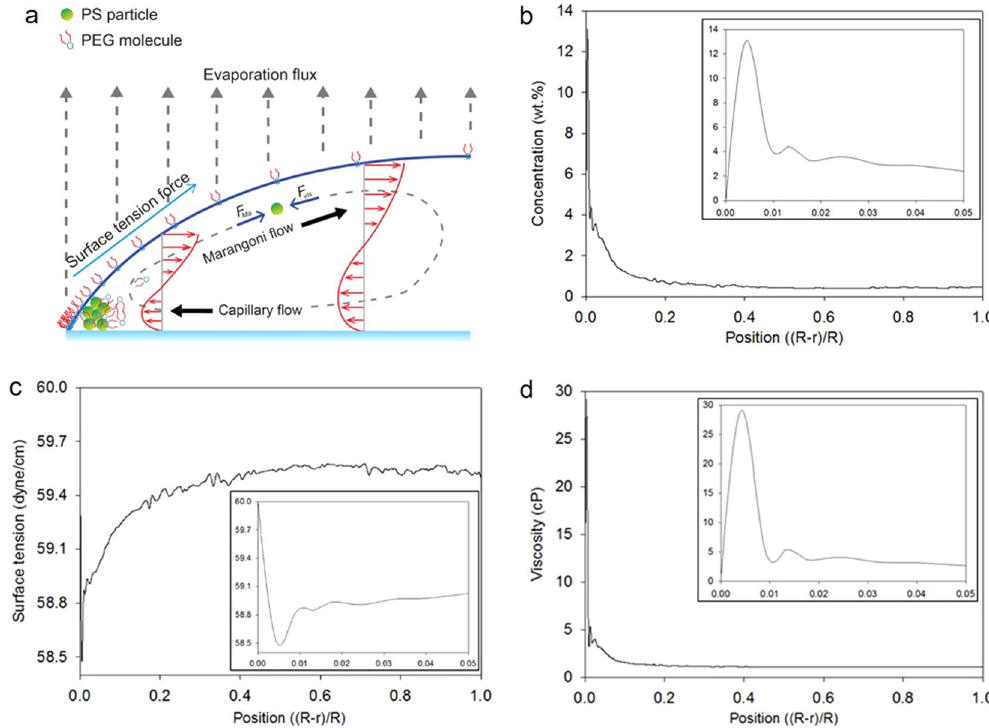
Figure 2. Mechanism of the PEG-induced Marangoni vortex. ( a ) Schematic image of the suspended particles and fluidic motion in the evaporating droplet system. ( b ) A profile of the PEG concentration by position. ( c ) A profile of the surface tension. ( d ) A profile of the viscosity. The expanded profiles near the edge are shown as the insets of each